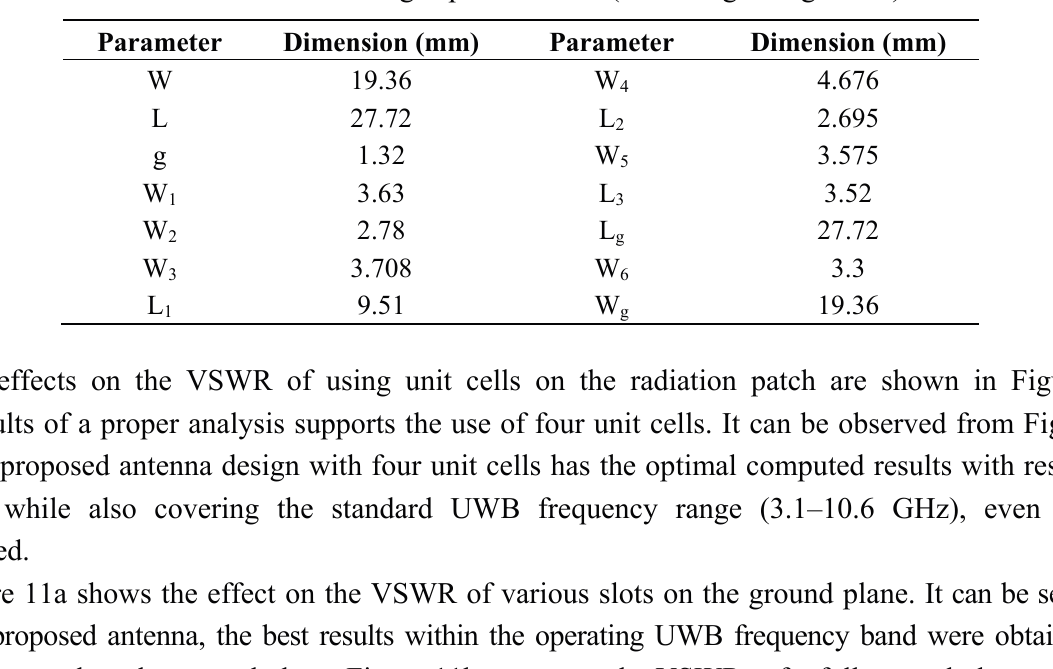
Figure 8. The proposed UWB antenna ( a ) Front view; ( b ) Bottom view; ( c ) Cross sectional view. Table 3. Antenna design specifications (according to Figure